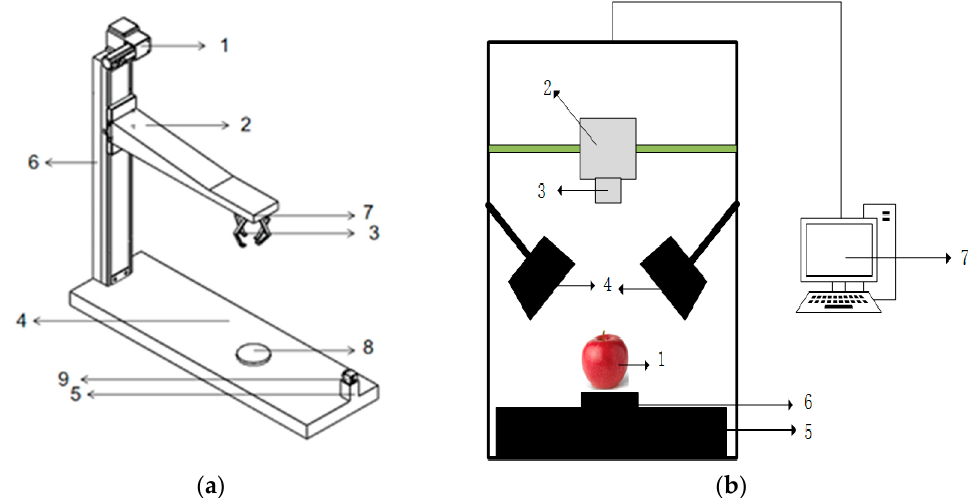
Figure 1. Fruit damage test bench and hyperspectral imaging system ( a ) fruit damage test bench 1. motor; 2. slider linkage mechanism; 3. robot; 4. Base; 5. camera placing table; 6. scale; 7. Solenoid; 8. fruit placing table; 9. high-speed camera; ( b ) hyperspectral imaging system. 1. apple; 2. camera; 3. lens; 4. light source; 5. shelf; 6. tray; 7. upper computer.